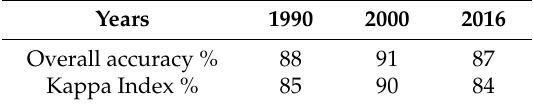
Table 2. Accuracy assessment of land use/cover between 1990, 2000 and 2016.